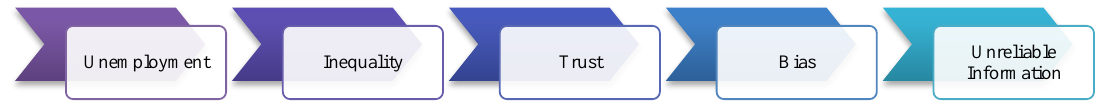
Figure 9. Challenges related to AI practices within the ethical